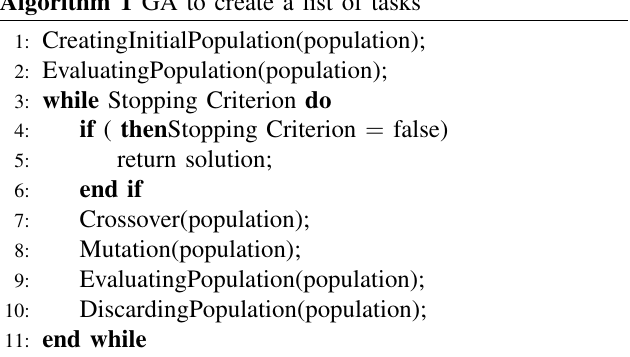
Algorithm 1 GA to create a list of